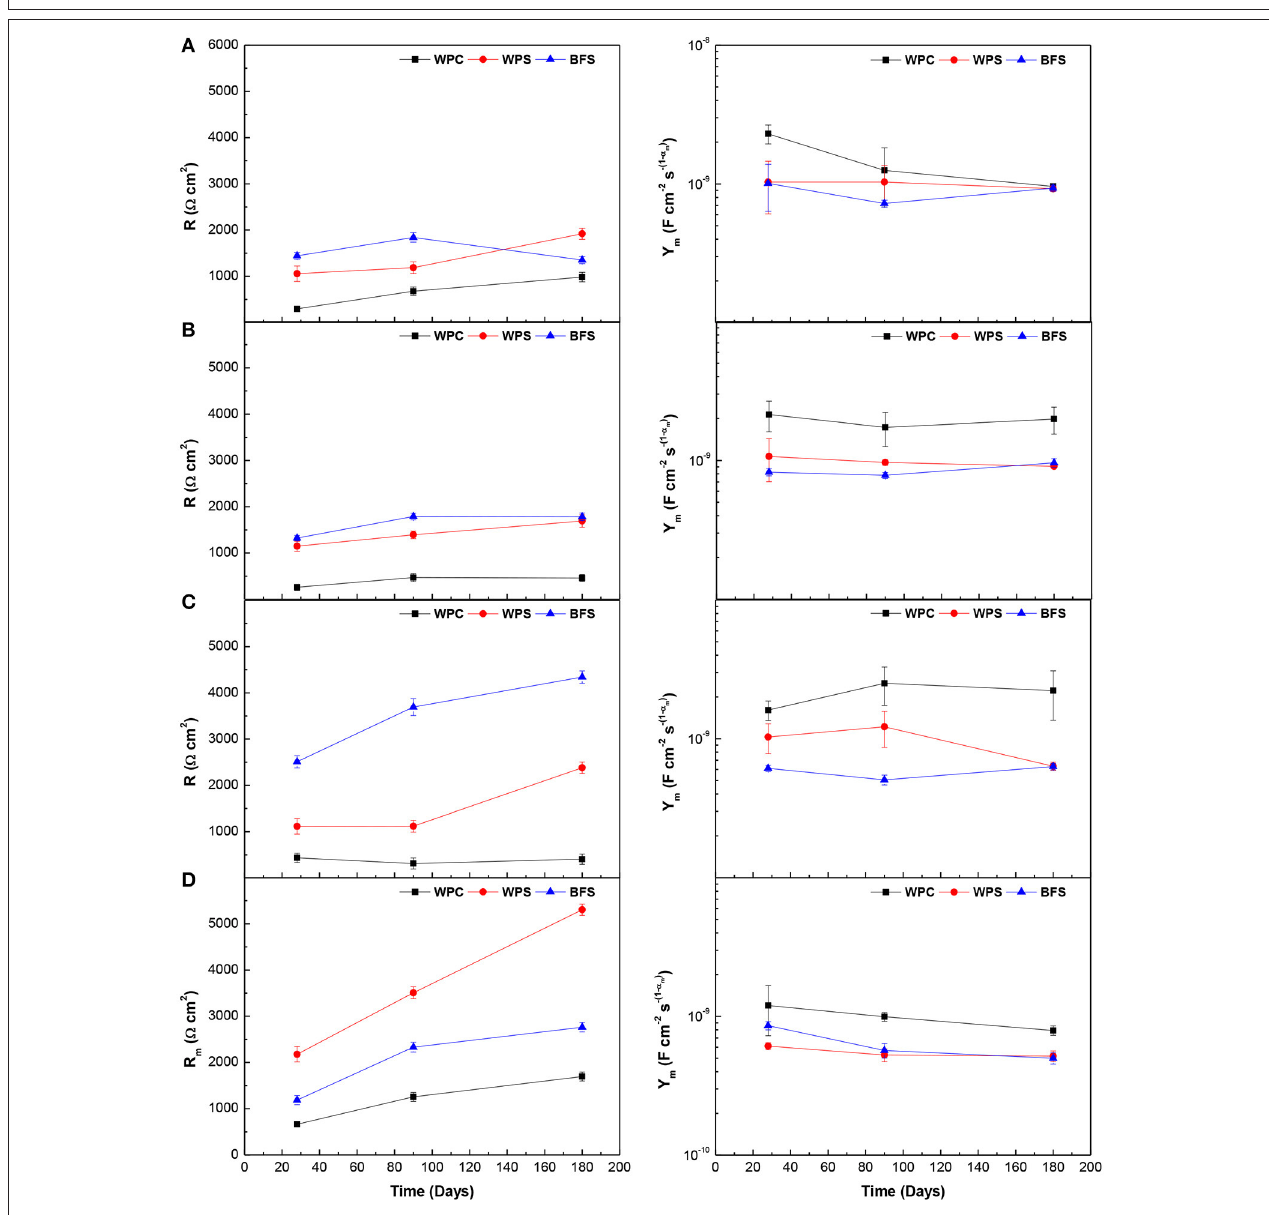
FIGURE 9 | Comparison of electrolyte and bulk matrix resistances R , and the mortar cover capacitance Y m , for the three types of mortar exposed to: (A) alkaline solution, (B) alkaline chloride-rich solution, (C) water, and (D) standard laboratory conditions. this simple electrochemical measurement from